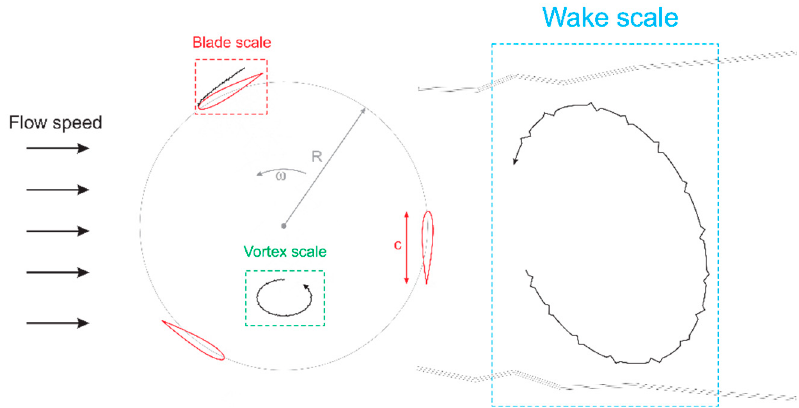
Figure A1. Flow scales in VAWT turbine flows. Turbine blades of chord c rotate with an angular velocity ω at a distance R from the turbine centre.